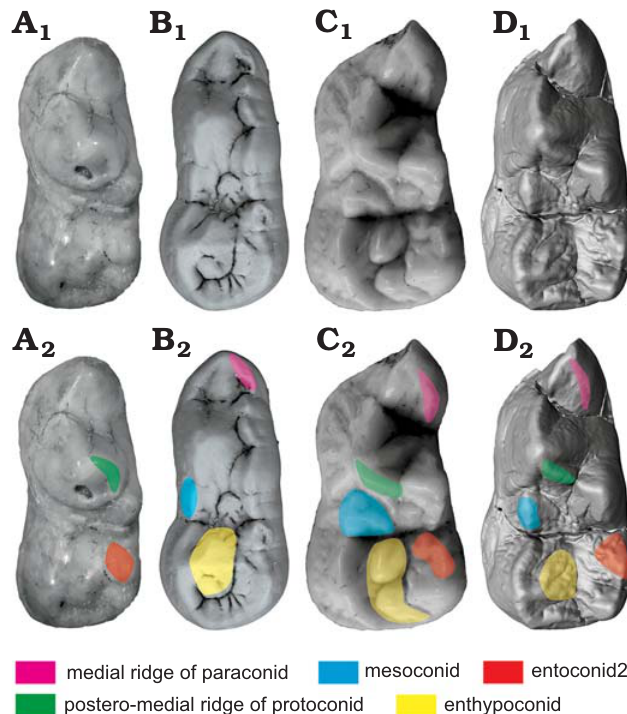
Fig. 8. Occlusal views of m1 homologous structures in cave bear (A, B) and giant panda (C, D) lineages. A . Ursavus tedfordi Qiu, Deng, and Wang, 2014 (HMV1453) from Huaigou, Gansu Province, Late Miocene. B . Ursus deningeri Von Reichenau, 1904 (NMM1956/907, photo Jan Wagner) from Mosbach 2, Germany, early Middle Pleistocene. C . Ailuropoda wuling- shanensis Wang and Lin, 1982 (IVPP V13459.10) from Longgu Cave, Jianshi, Hubei Province. D . Ailu rarctos lufengensis Qiu and Qi, 1989 (IVPP V25032) from Lufeng, Yunnan Province, Latest Miocene. A 1 –D 1 , photographs; A 2 –D 2 , photographs with homologous structures indicated. Not to